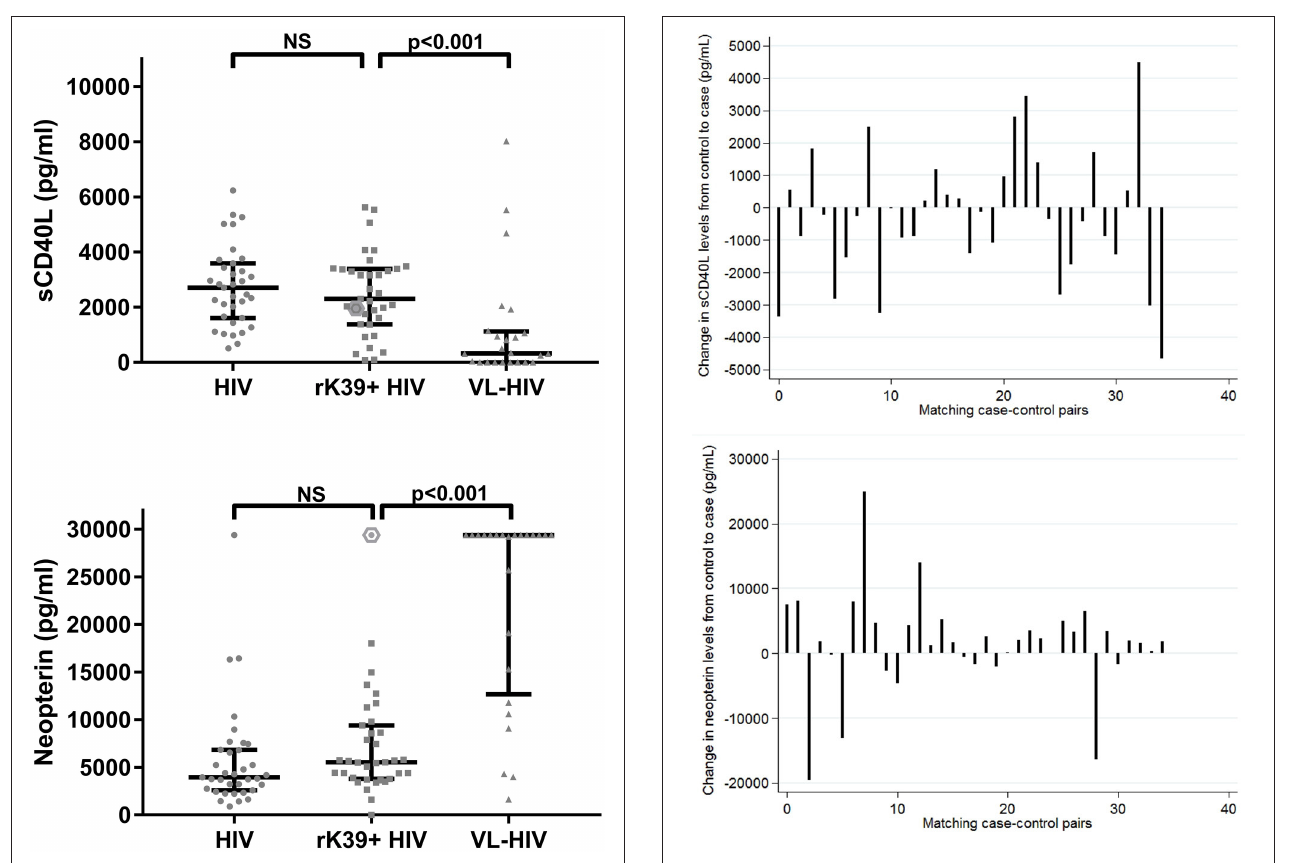
FIGURE 2 | Change in serum sCD40L (top) and neopterin (bottom) concentrations per matched control-case pair. Controls: rK39– HIV patients Cases: rK39 + HIV patients. Patients were matched on sex, months on ART, ART regime, and CD4 + T-cell